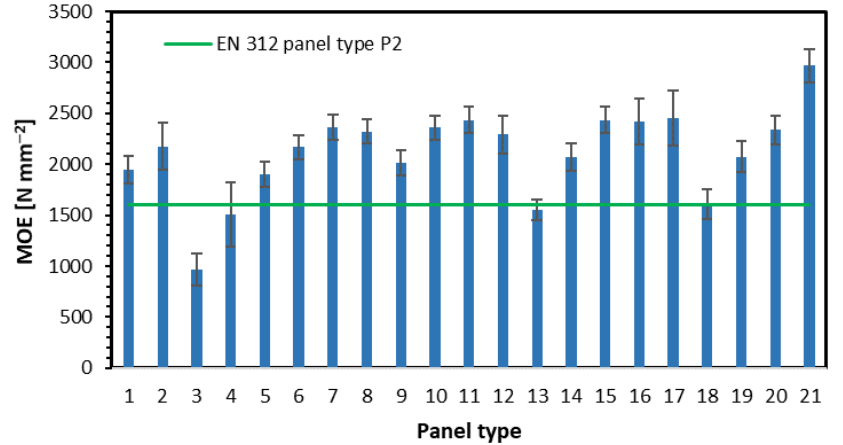
Figure 4. The modulus of elasticity of tested panels.